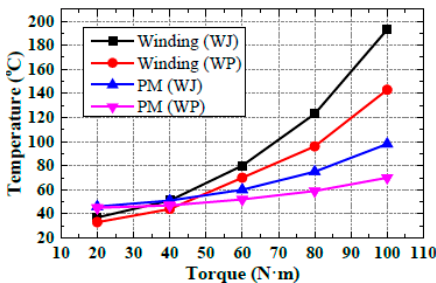
Figure 17. Thermal advantage with the water cold plates compared to water jacket-cooling [81].